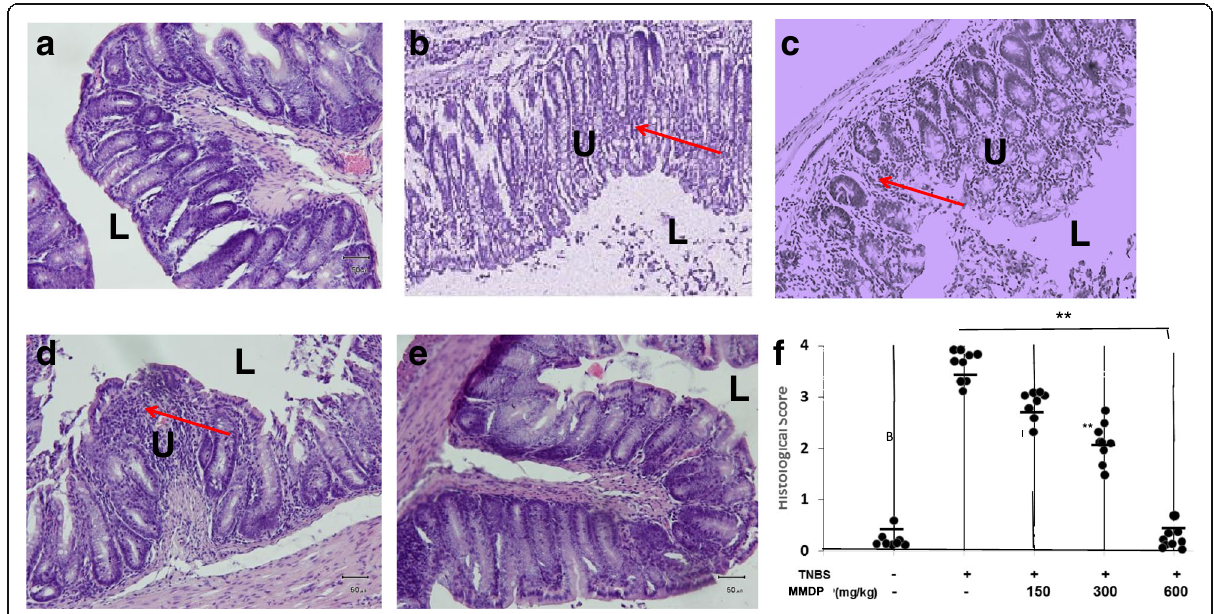
Fig. 3 Histological changes in mice with acute trinitrobenzene sulfonic acid (TNBS) induced colitis after 7 days of treatment with mango mistletoe Dendrophthoe pentandra (MMDP) extract. A. Mice were sacrificed at the end of 7 days, and the colons were excised and fixed. Representative hematoxylin and eosin (H&E)-stained colonic sections of mice treated with or without the MMDP extract are shown. a : Mice were given untreated water as the control; b : Mice were given TNBS only; c – e : Mice were treated with MMDP extract (150, 300, and 600 mg/kg) respectively are shown and the averages of each group are shown as horizontal bars (total, n = 6). f . Histological scores in colonic sections from each group stained with H&E are also shown. L: Gut Lumen, U: Ulcer, Arrow: inflammatory infiltrate. The groups are significantly different (** p < 0. 001, magnification 200×)